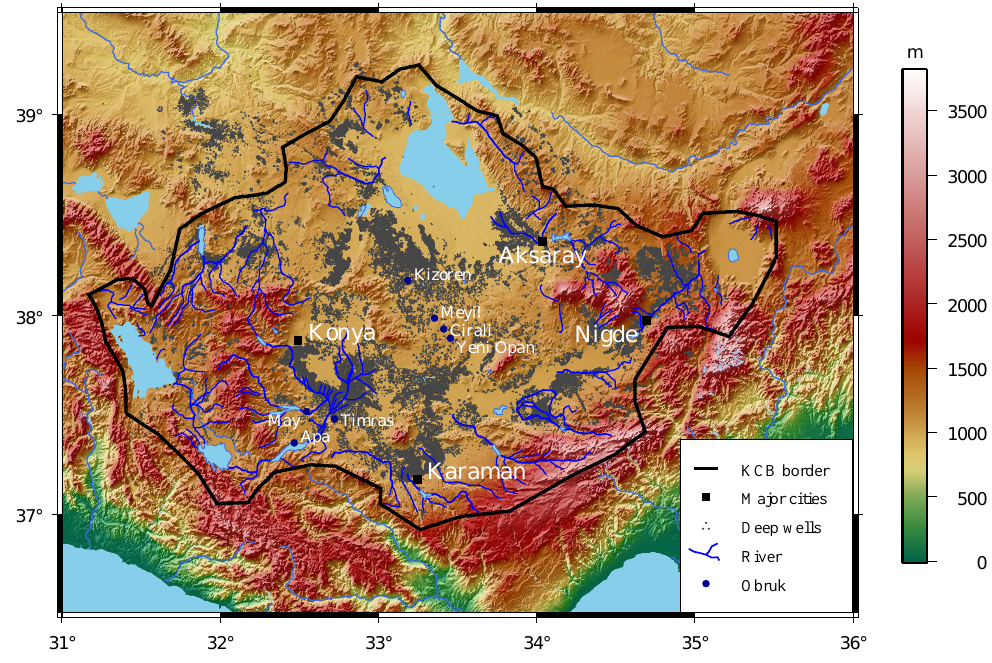
Fig. 1. Konya Closed Basin and distribution of deep wells used for groundwater